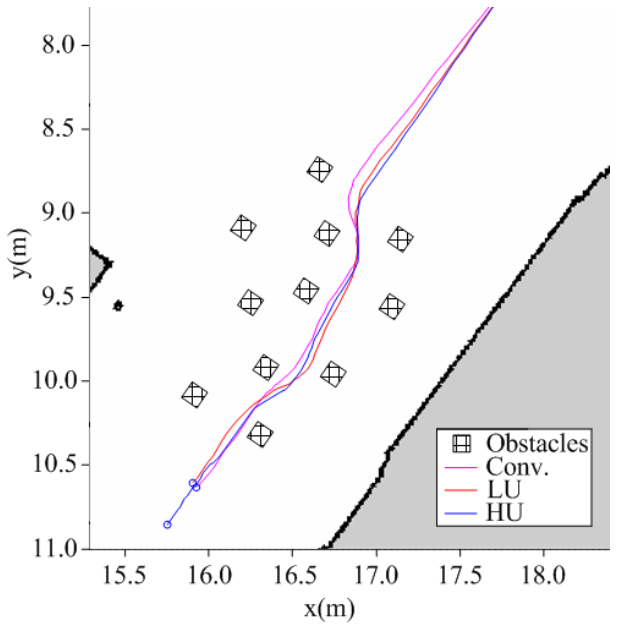
Figure 9. Resultant path.